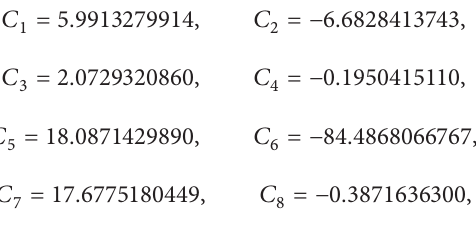
Table 9: Comparison between the values of 𝐹 Type of